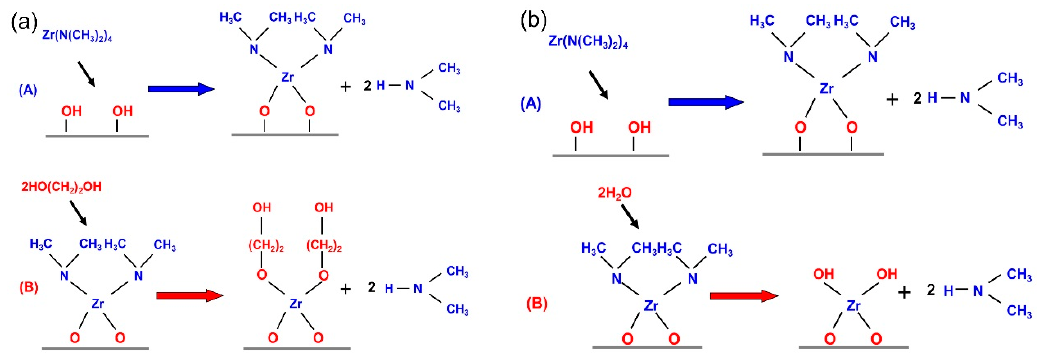
Figure 2. A schematic diagram of the mechanism of reaction exhibited by distributed Bragg reflector (DBR) films of ( a ) the zircone layer and ( b ) the ZrO 2 layer.